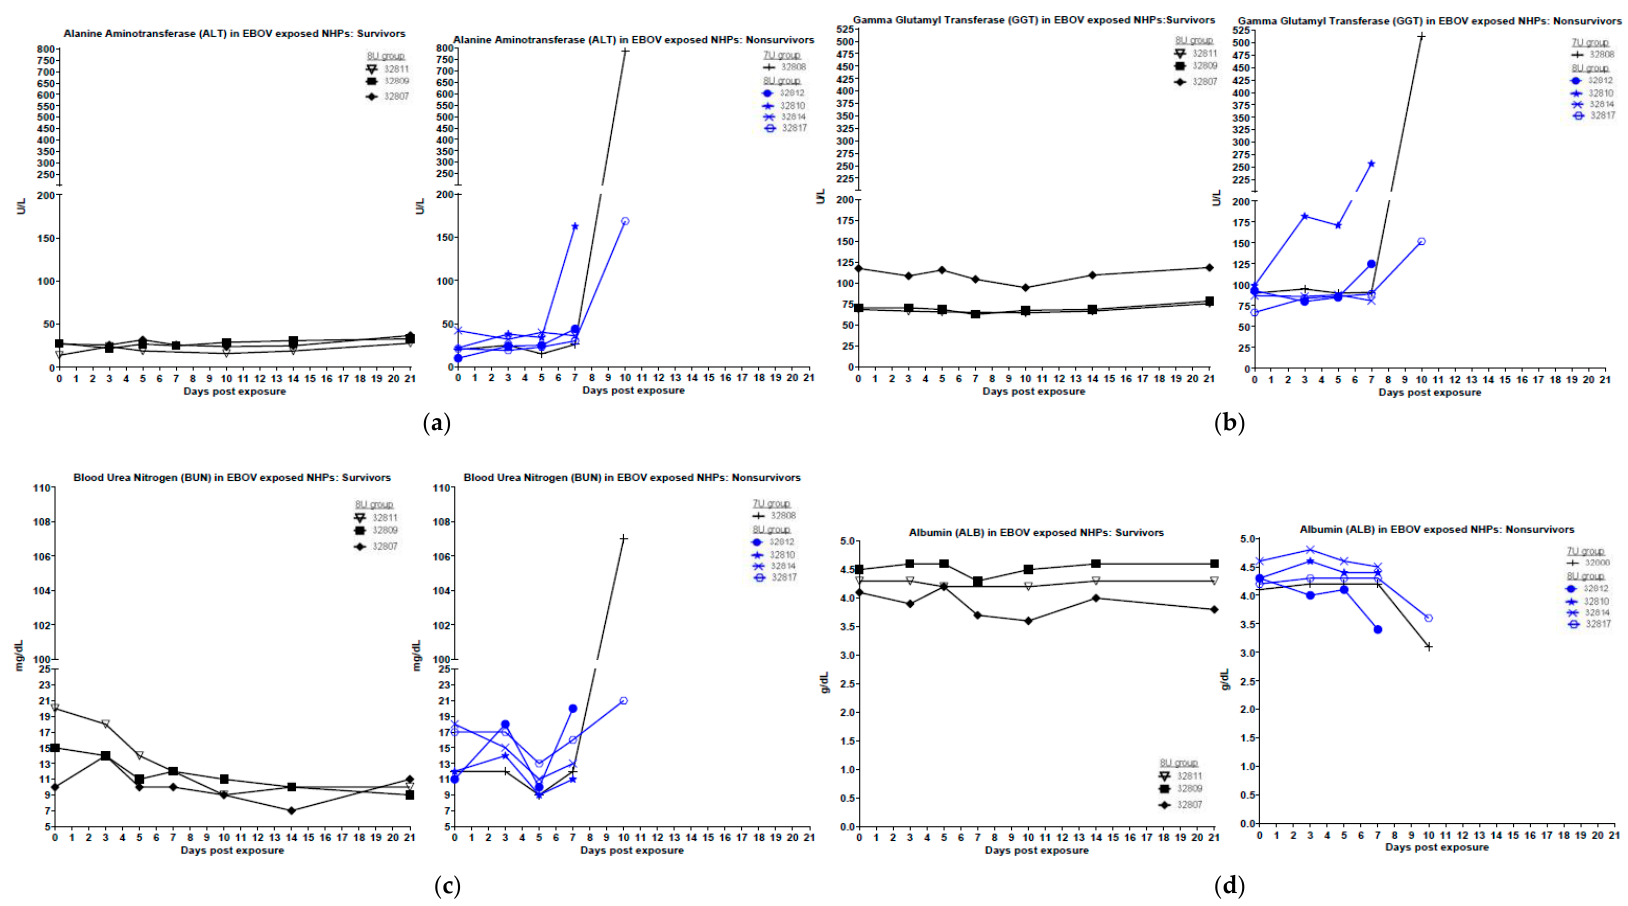
Figure 6. Clinical chemistry parameters in Macaca fascicularis exposed to low doses of Ebola virus (EBOV). M. fascicularis were experimentally exposed to 0.01 plaque forming units of EBOV with either 7-uridine or 8-uridine genotypes. During each scheduled sedation, and when possible at the time of death, blood specimens were collected and analyzed. Results of clinical chemistry analysis for all EBOV-exposed animals throughout the course of the study are shown. No data are available for animal 32811 on day 7 post-exposure. NHPs—nonhuman primates. ( a ) Alanine aminotransferase (ALT) in EBOV-exposed NHPs. ( b ) γ glutamyl transferase (GGT) in EBOV-exposed NHPs. ( c ) Blood urea nitrogen (BUN) in EBOV-exposed NHPs. ( d ) Albumin (ALB) in EBOV-exposed NHPs.